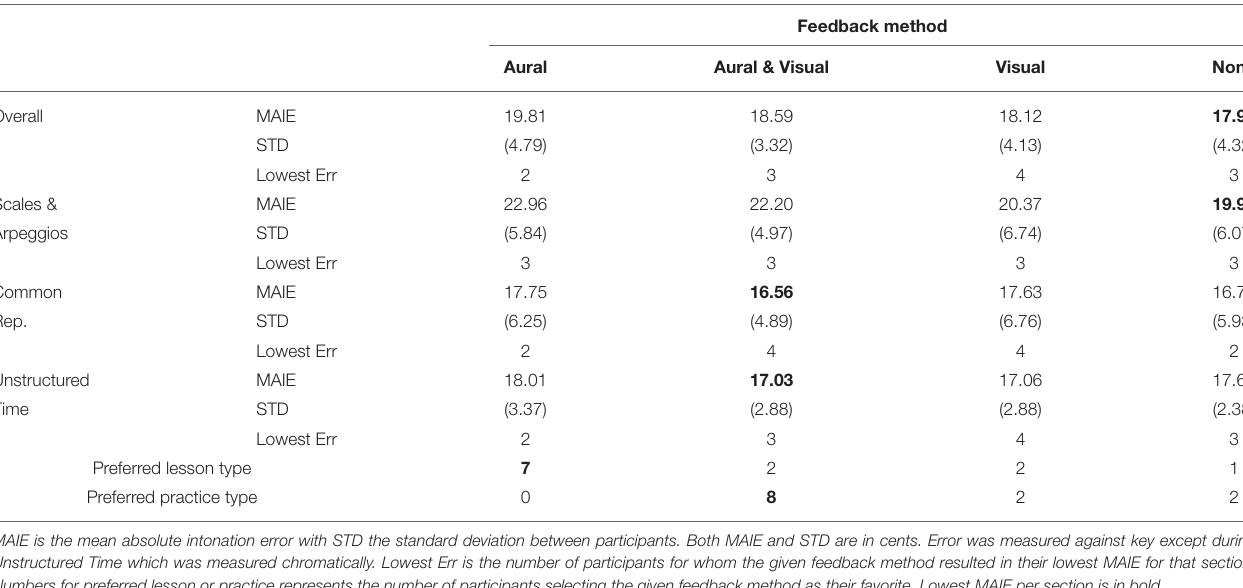
TABLE 2 | Results of study with beginners using augmented violin with variable feedback.